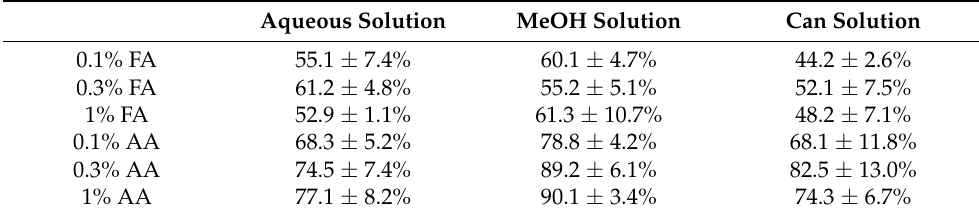
Table 1. Extraction recoveries of TTX with different conditions, including selectivity of acids and co-solvents. FA means formic acid; AA means acetic